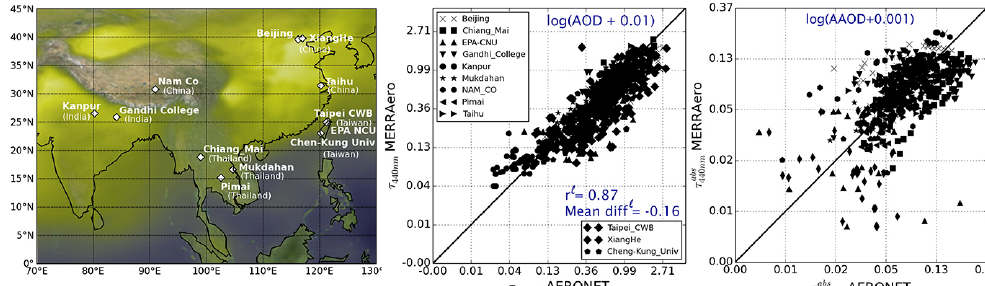
Figure 15. Same as Fig. 5 but for the Asian